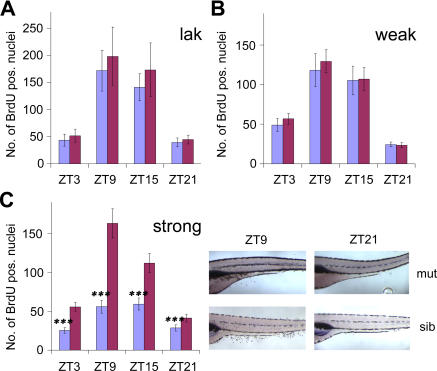
Circadian Cell Cycle Rhythms in Blind Zebrafish Mutants(A) Quantification of BrdU-labeled nuclei in lak mutant larvae and wild-type siblings at four circadian time points. The mean number of positive nuclei between swim bladder and anus (y axis) was plotted against ZT, hours after lights on, lights off at ZT12) (x axis) for mutant (blue) and sibling (red) larvae. Error bars indicate the 95% confidence interval for the mean, and asterisks indicate the statistical significance of differences between mutants and wild-type siblings as measured by the Mann-Whitney-Test. ***, p < 0.001.(B) Quantification of BrdU incorporation analogous to (A) for mutants and siblings of the weak rx3 allele.(C) Left: quantification analogous to (A) for strong rx3 mutants. Right: representative examples of whole-mount stainings used for the quantification. Mutant (mut) and sibling (sib) larvae at peak (ZT9) and trough (ZT21) points of the cell cycle rhythm are shown. Mutant larvae appear darker, because their melanophores are expanded (lack of visual background adaptation in blind fish). A high-resolution image of this part of the figure is provided as Figure S1.Pooled results from two (A), four (B), and nine (C) independent experiments are shown.